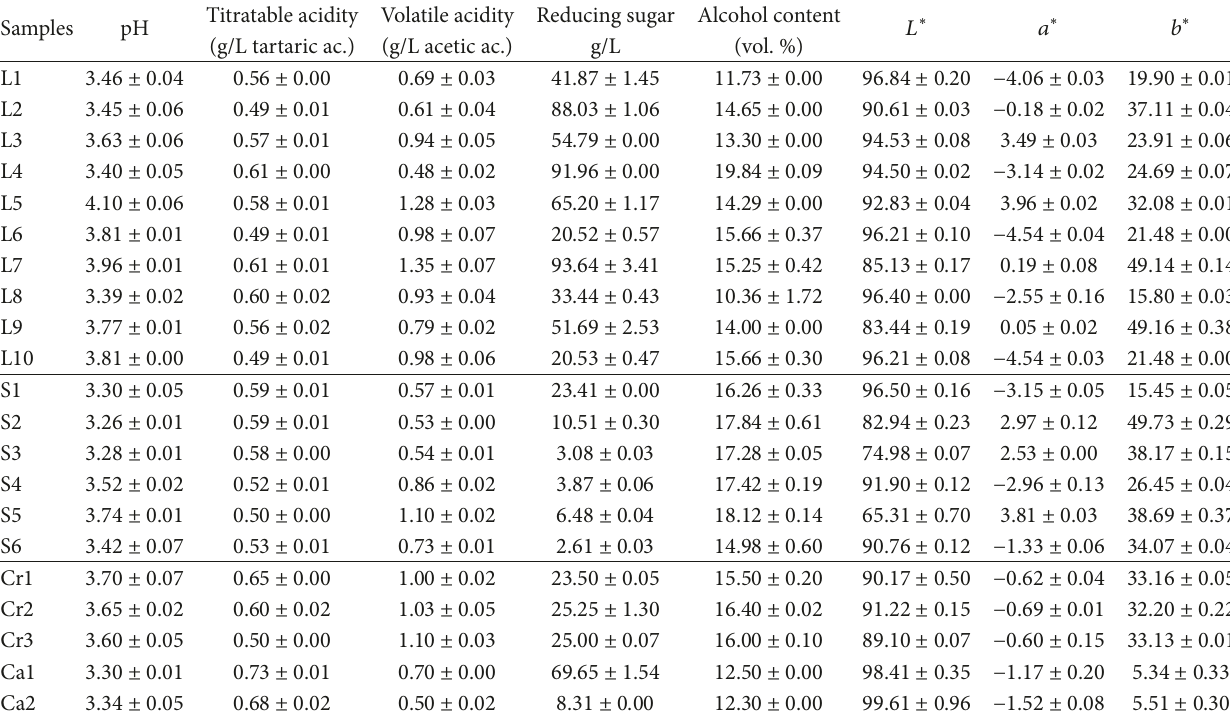
Table 1: Mean values and standard deviation of the physicochemical parameters.